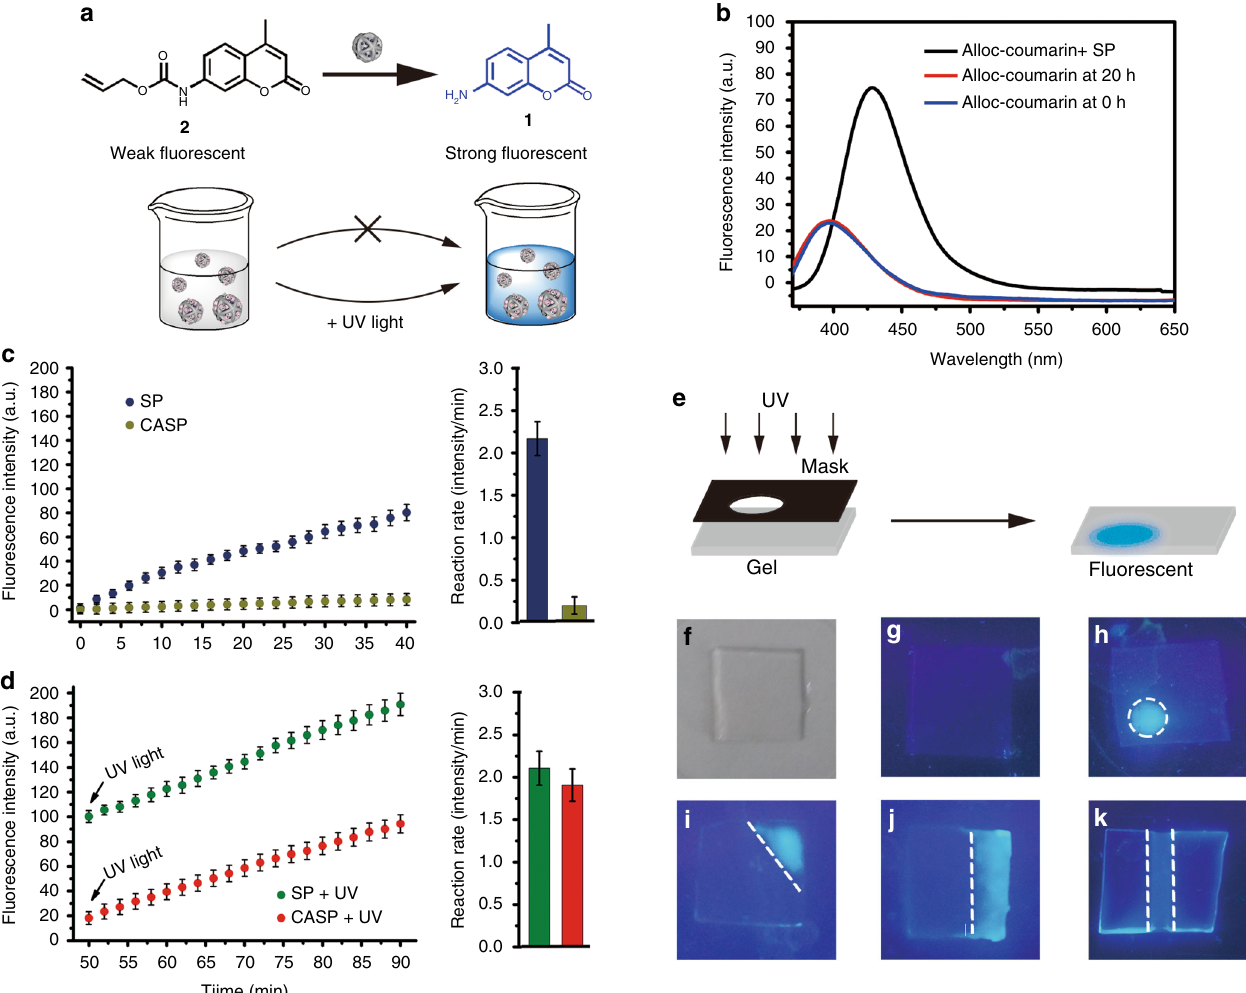
Fig. 2 Catalytic ef fi cacy of SP and CASP nanoparticles in vial. a SP and CASP catalyzed allylcarbamate cleavage of N-alloc-cumarin, 2 to generate a fl uorescent compound, 1 , in vial. b The fl uorescent spectra of alloc-coumarin alone at 0 h (blue) or 20 h (red) and reacted with SP for 20 h (black). c Fluorescence was increased when the system added SP, while CASP showed no signi fi cant change during 0 – 40 min. d After irradiation with UV light for 10 min, the catalytic activity of CASP was restored and became similar to SP, while UV light had no effects on SP. The attached graph re fl ected the reaction rates of SP and CASP before and after the UV light. Data were presented as mean ± s.d. ( n = 3). e The fl uorescent gel experiments: the polyacrylamide gel (PAMG) was prepared in the presence of CASP and N-alloc-coumarin ( f ). Under ambient conditions, the PAMG showed minimal fl uorescence ( g ), when irradiated the gels with UV light under a mask that featured lower-left cycle ( h ), upper-right triangle ( i ), right rectangle ( j ), and middle rectangle ( k